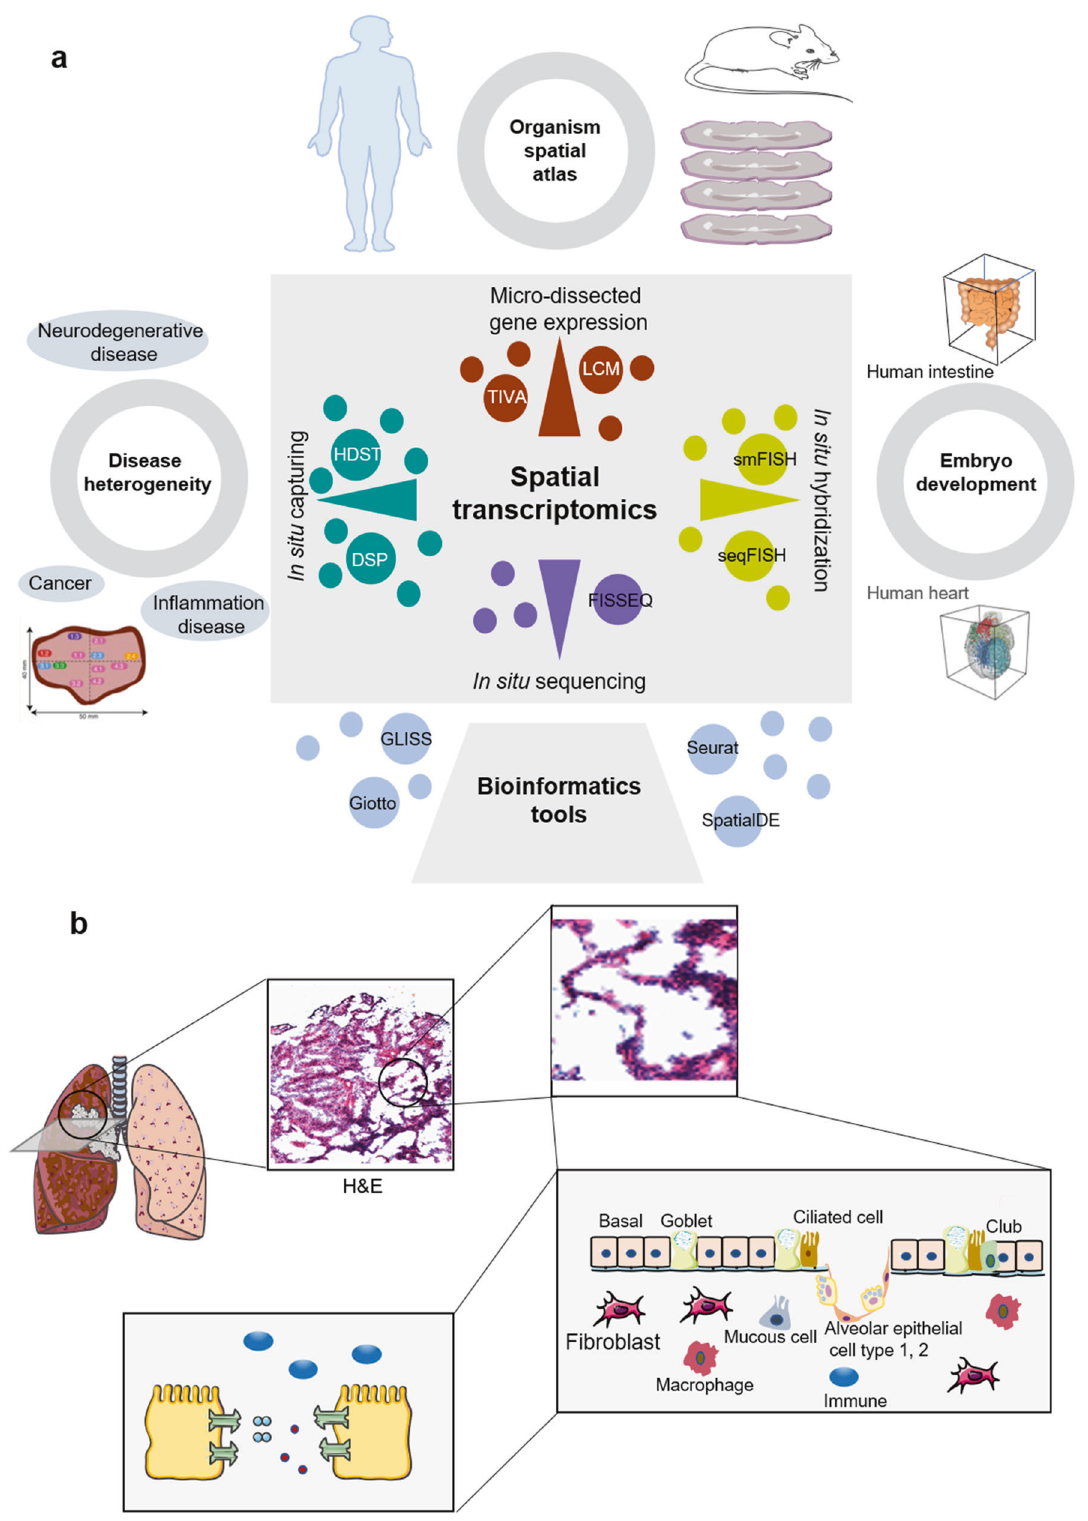
Fig. 6 Summary of work fl ows during applications for spatial transcriptomics. a Spatial transcriptomics techniques are mainly used to solve spatial heterogeneity of diseases, biological spatial transcriptome map, and embryonic development spatial blueprint. The four ST techniques include micro-dissected gene expression, in situ hybridization, in situ sequencing and in situ capturing. Different techniques are used according to different sample characteristics and needs, and a variety of biological tools are used for analysis. b A simulation diagram of tumor microenvironment. ST technology assists in understanding the spatial location of tumor cells and gene expression as well as intercellular molecular communication between cells within the microenvironment. For example, H&E staining in lung tissue provides sample pathological information and assesses sample quality, and further integrates cell grouping and location information analysis such as basal, goblet, ciliated cell, alveolar epithelial cells type 1, 2 and other cells, so as to provide a better understanding of the molecular communication mechanisms in the cellular microenvironment Signal Transduction and Targeted Therapy (2022)